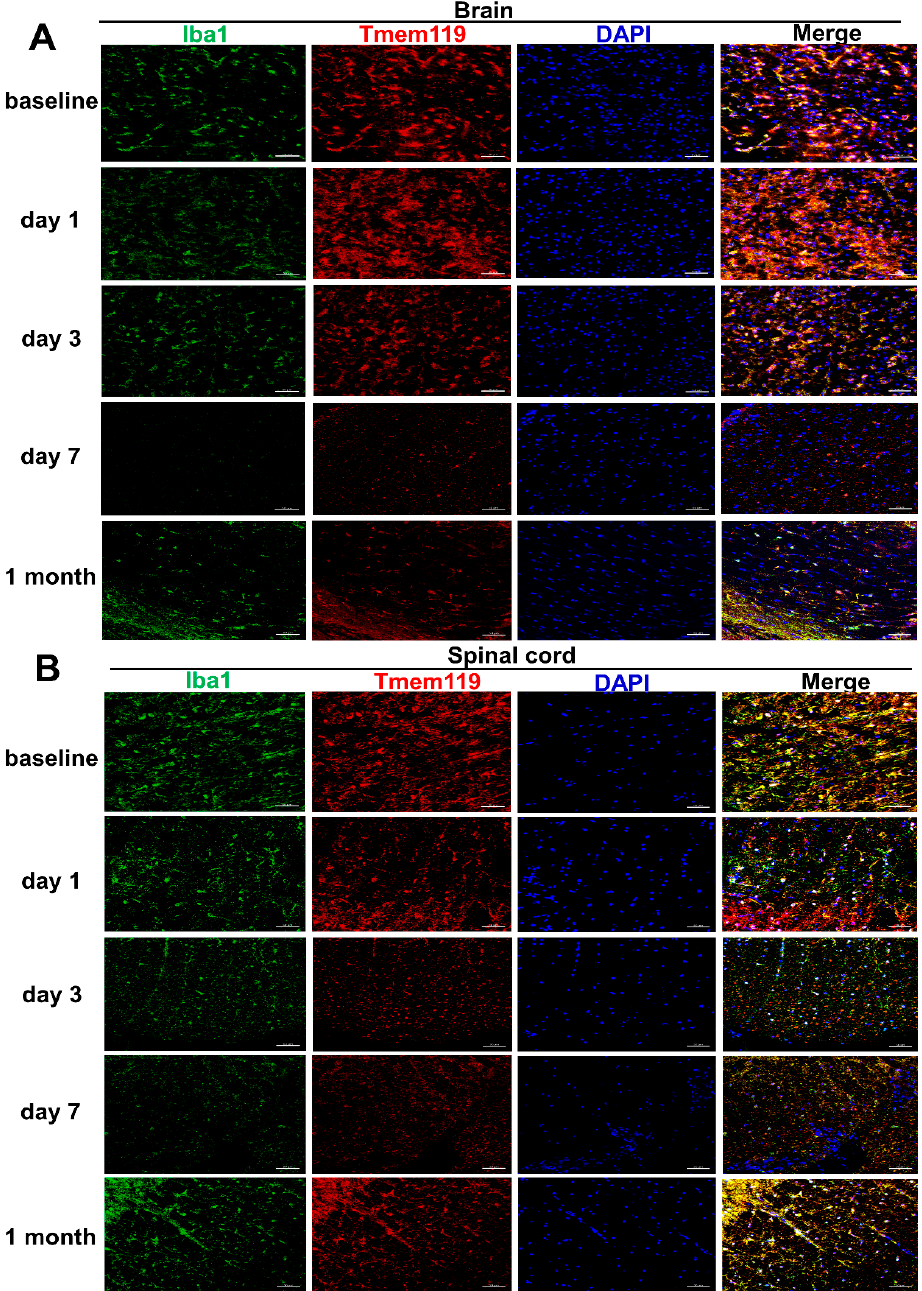
Figure 2. Microglia are effectively depleted by day 7 after tamoxifen injections and repopulated 1 month later in Cx3cr1 CreER/+ Rosa26 DTA/+ mice. An example of each time point (baseline, day 1, 3, 7 and 1 month) of double immunofluorescent staining of Iba1 (green) and Tmem119 (red) of Cx3cr1 CreER/+ Rosa26 DTA/+ and Cx3cr1 CreER/+ central nervous system (CNS) tissues followed by three consecutive subcutaneous tamoxifen injections. Representative images showed microglia in the cerebral cortex from coronal sections along center line ( A ) and microglia in the spinal cord white matter from mid thoracic transversal sections ( B ). n = 5, 3, 4, 6 and 3 mice at baseline, day 1, day 3, day 7 and day 28 time points, respectively. Both male and female mice were used. Data are representative of two independent experiments. Scale bars represent 50 μ m.